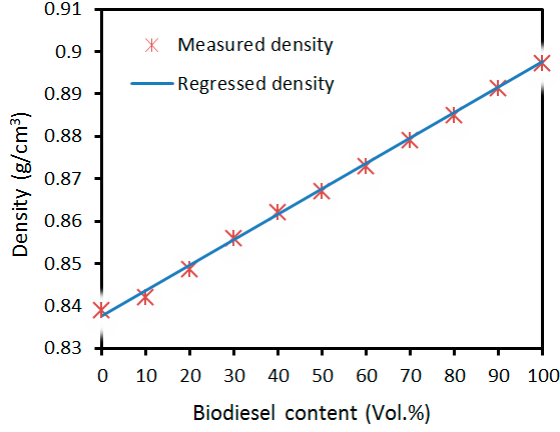
Figure 6. The density of biodiesels blended with diesel fuels.